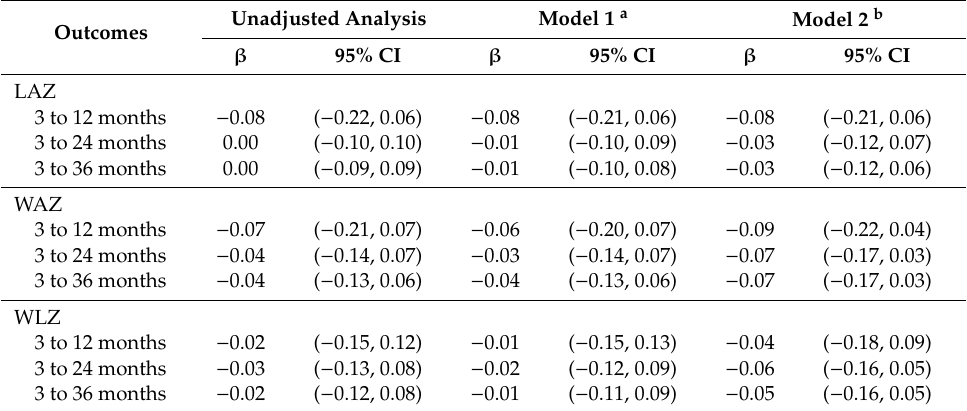
Table 3. E ff ects of maternal prenatal multi-micronutrient supplementation compared with iron–folic acid supplementation on infant linear growth within di ff erent age